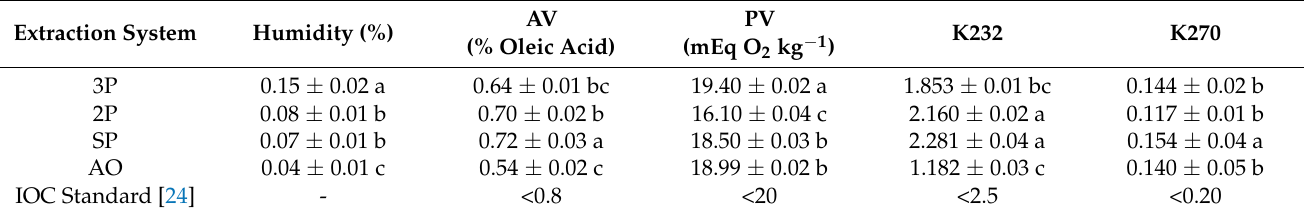
Table 1. Mean values of routinely measured quality indices: namely humidity, acid value (AV), peroxide value (PV), UV absorption coefficients K232 and K270. Results are expressed as mean ± SD (n = 9). Within each column, values followed by the same letter are not significantly different at p <